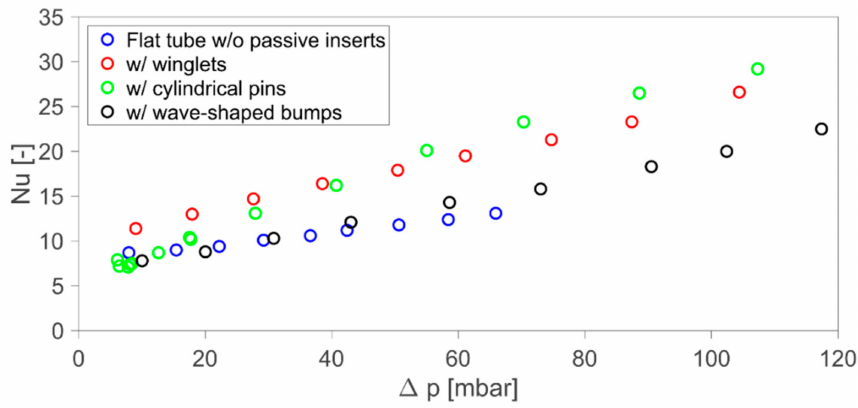
Figure 14. Efficiency in terms of Nusselt number Nu vs. pressure drop ∆ p for Pr = 13. The results for the flat tube with cylindrical pins and the flat tube with “winglets” are quite similar. For low Reynolds number, the Nusselt number was slightly higher when using “winglets”, while the pin tube showed highest values above approximately 50